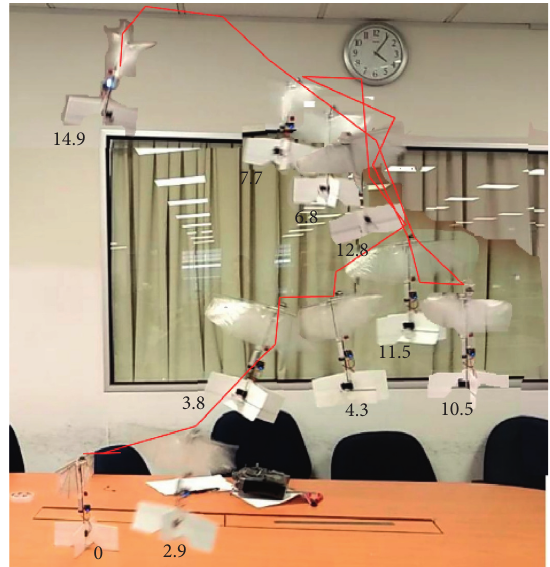
Figure 16: Cross-shaped tail fin flapping-wing flight with control.